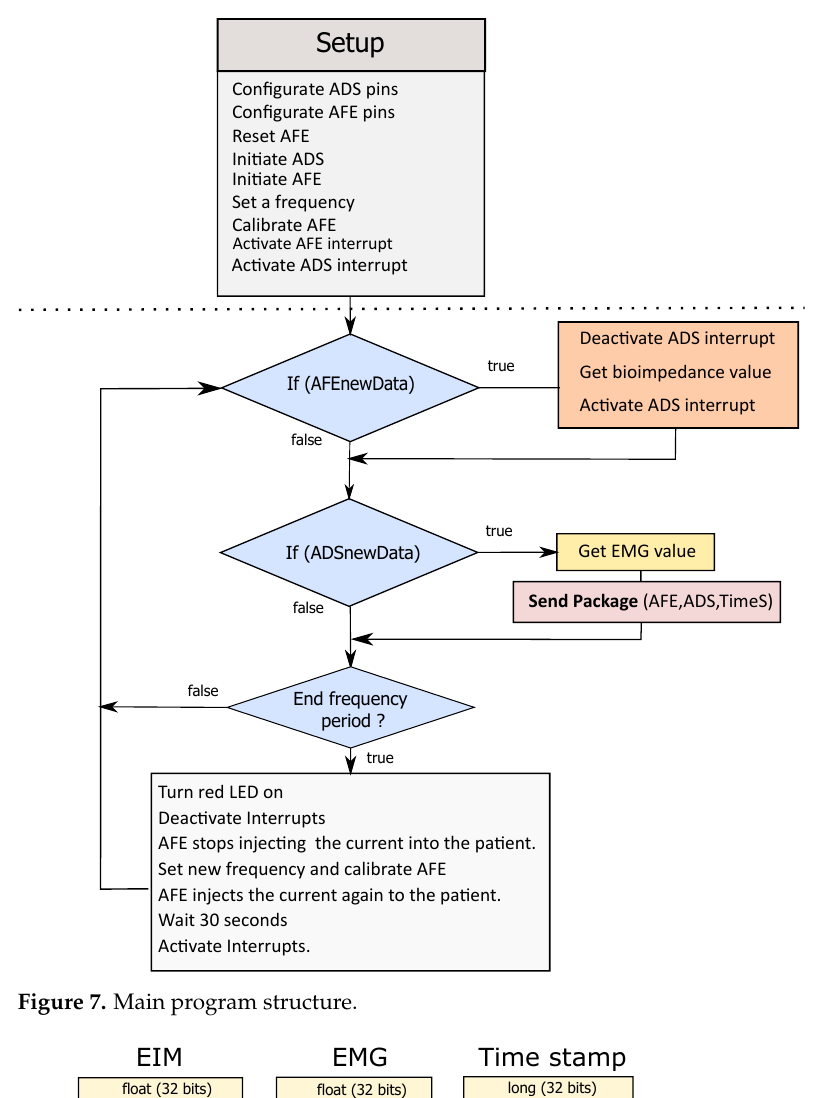
Figure 7. Main program structure.